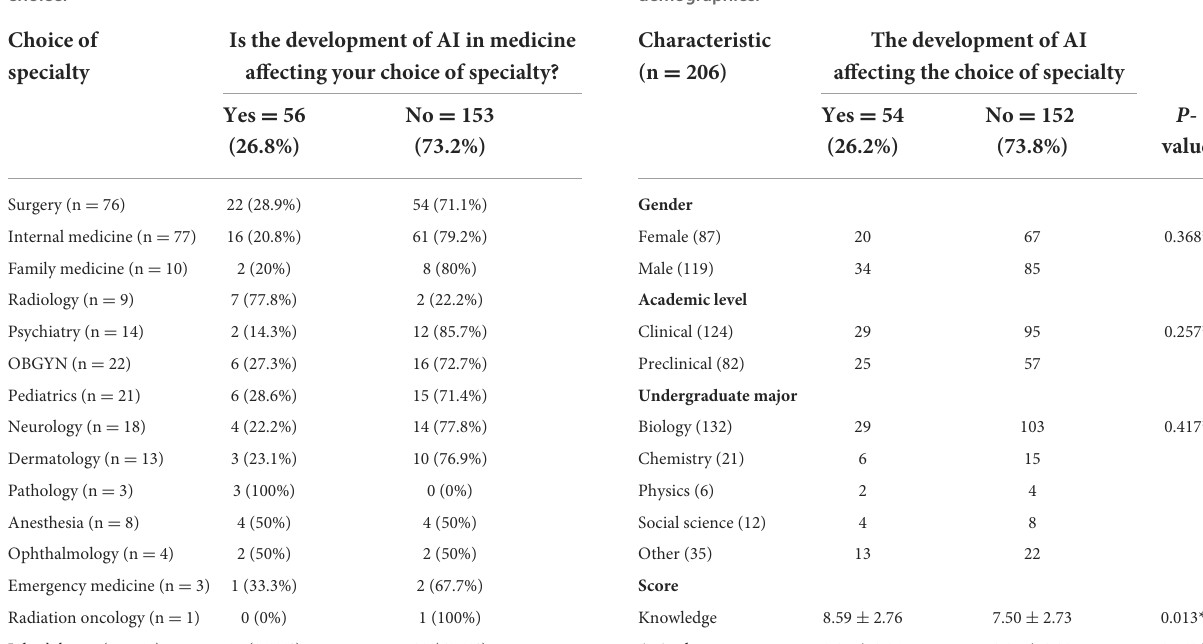
TABLE 3 Differences in the effect of AI on choice of specialty based on